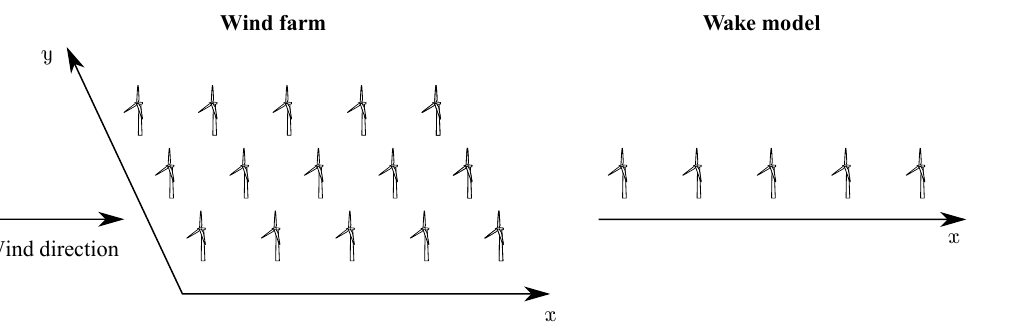
Figure 1. Diagram of a regular wind farm (left panel) with N = 5 rows and M = 3 columns of turbines and the corresponding row-averaged wake model representation (right panel). Each column is aligned with the streamwise coordinate x , and each row is aligned with the spanwise coordinate y